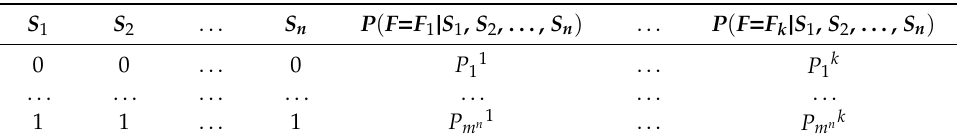
Table 1. CPT of multi-state fuzzy